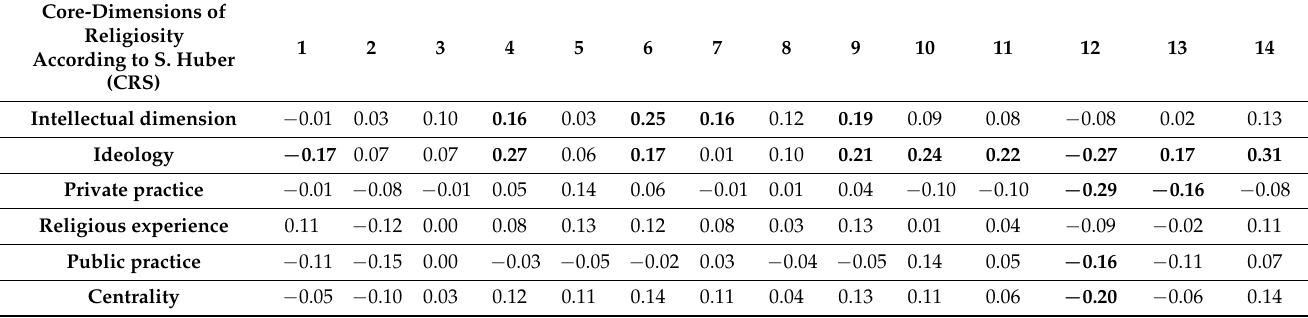
Table 3. The value of correlation (r) between the respondents’ religiosity and their opinions on